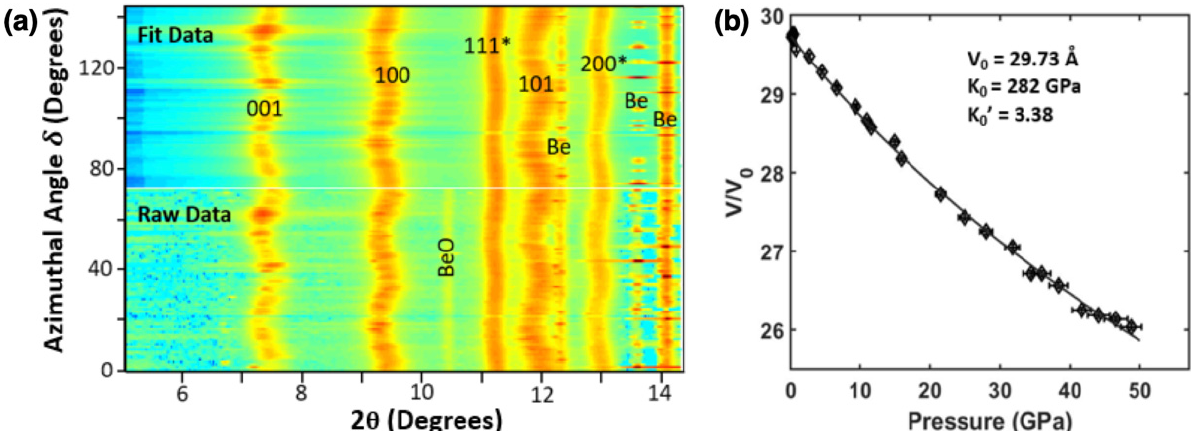
Figure 3. ( a ) R-XRD image of raw and Rietveld refined fits of HfB2 and Pt(*). Beryllium gasket peaks are labelled with beryllium oxide impurity. ( b ) Hydrostatic pressure volume curve of HfB 2 to 50 GPa with the fitted 3rd Order Birch–Murnaghan equation of state. The fitted parameters are shown in the inset.